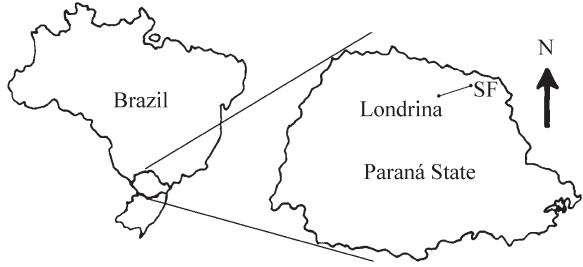
Figure1 -LocationofSãoFranciscoStatePark(SF)andLondrinadistrict containing Godoy’s Forest State Park and the Arthur Thomas Municipal Park. The sites were all in the north of the southern Brazilian state of